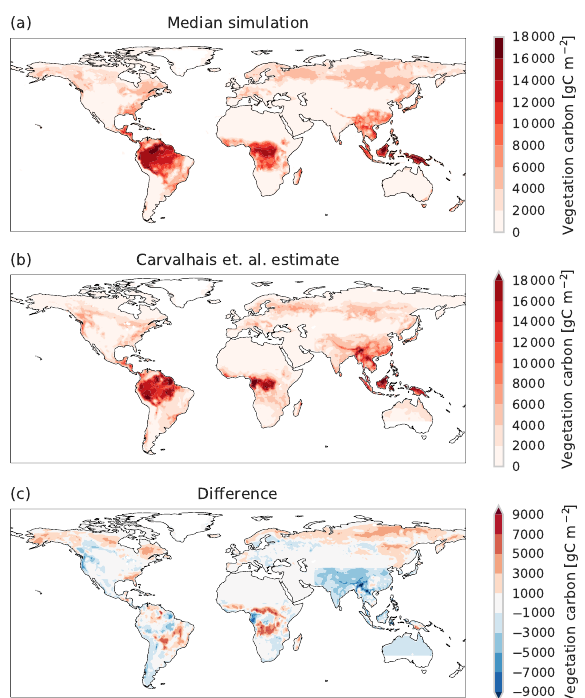
Figure 10. The skill weighted median M net , net vegetation carbon distribution averaged between 1982 and 2005 (a) , compared to the Carvalhais et al. (2014) vegetation carbon estimate (b) . The correla- tion of the estimates is r 2 = 0 . 83. The absolute difference is shown in panel (c)